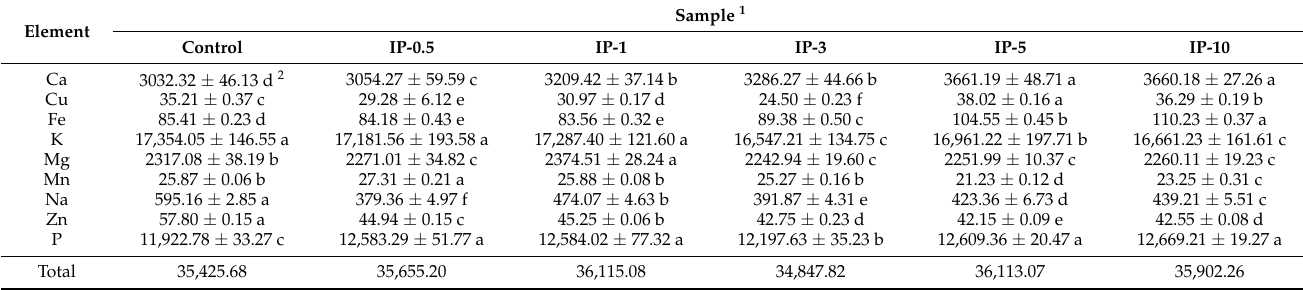
Table 3. Mineral contents (mg/kg of dry weight) of soybean sprouts cultivated after different concentrations of illite